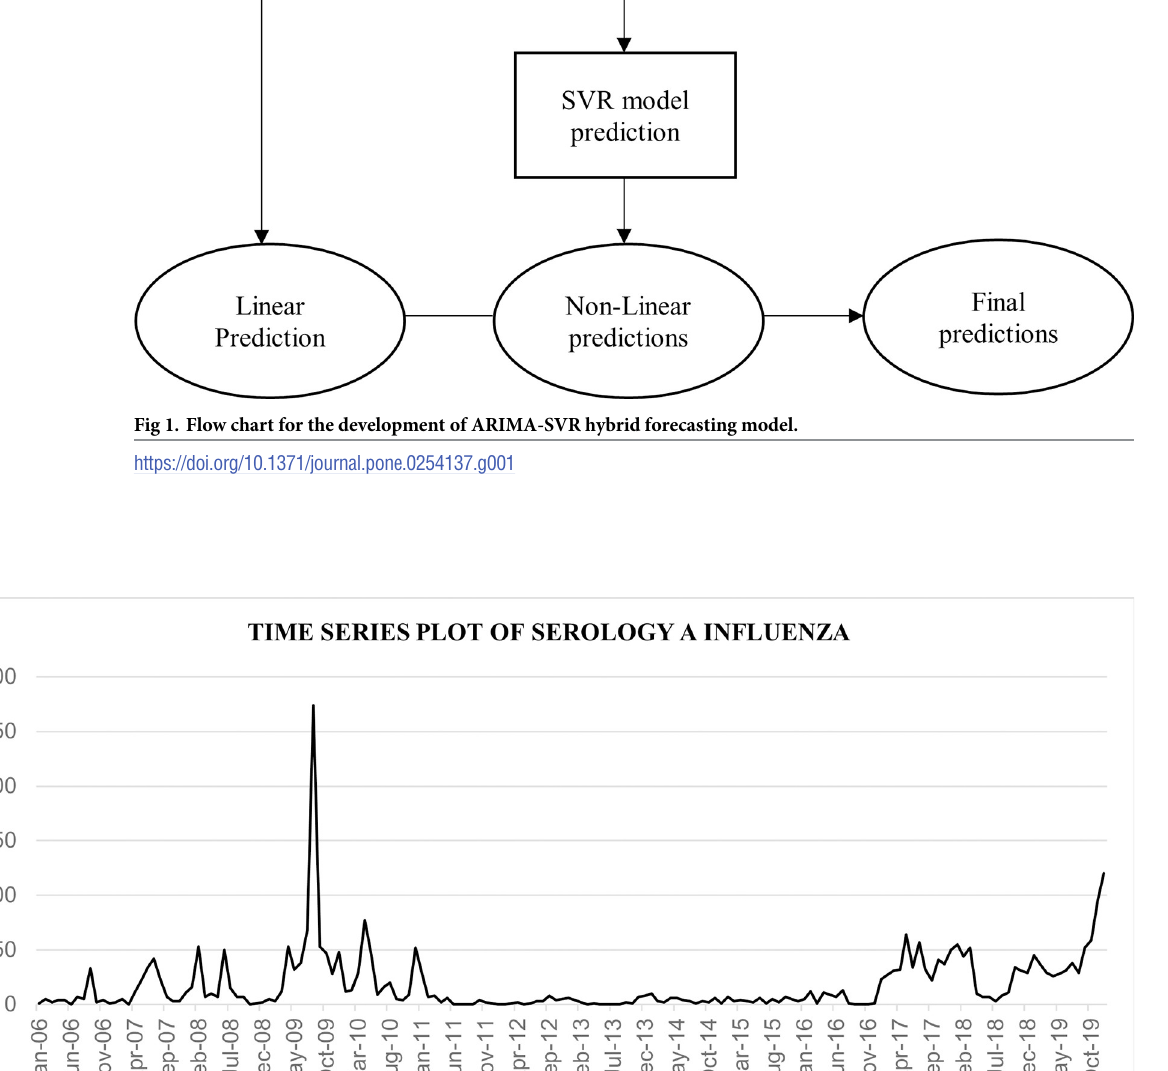
PLOS ONE | https://doi.org/10.1371/journal.pone.0254137 July 21,